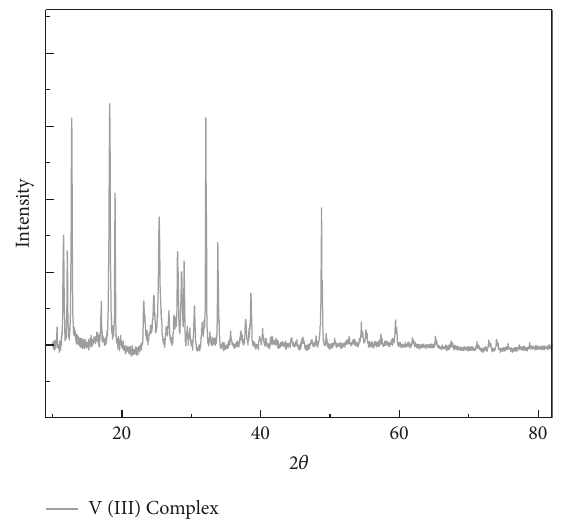
Figure 12: XRD pattern of V(III) compound.